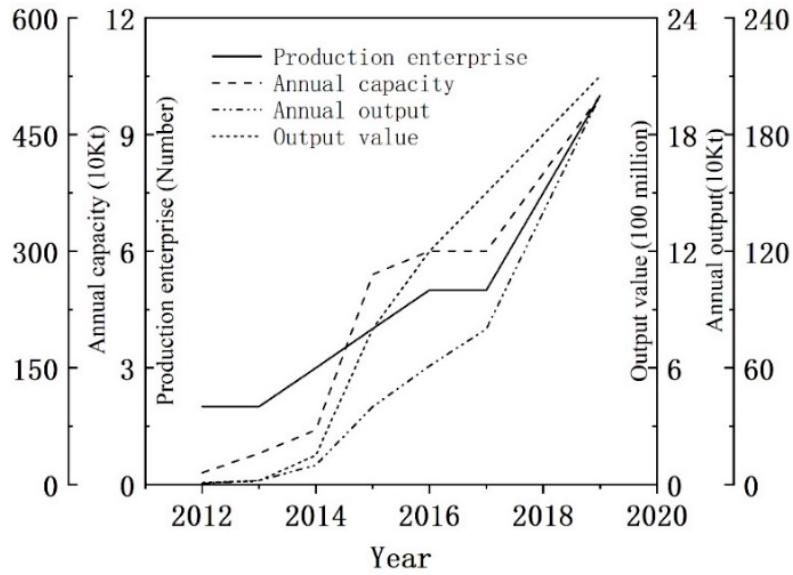
Figure 1. Development and utilization of mineral water resources in Antu county.